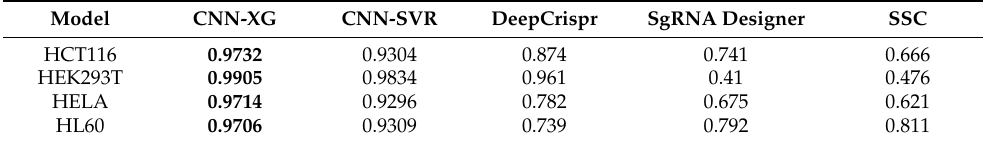
Table 2. AUROC values for test scenario 1.